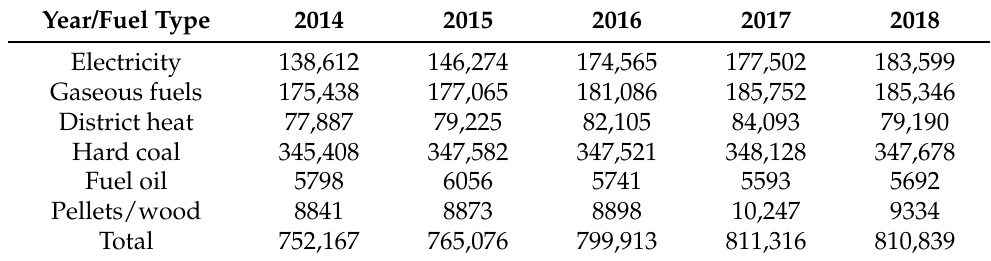
Table 1. Balance of energy consumption by fuel type in the city of Nowa Ruda [GJ] [23].